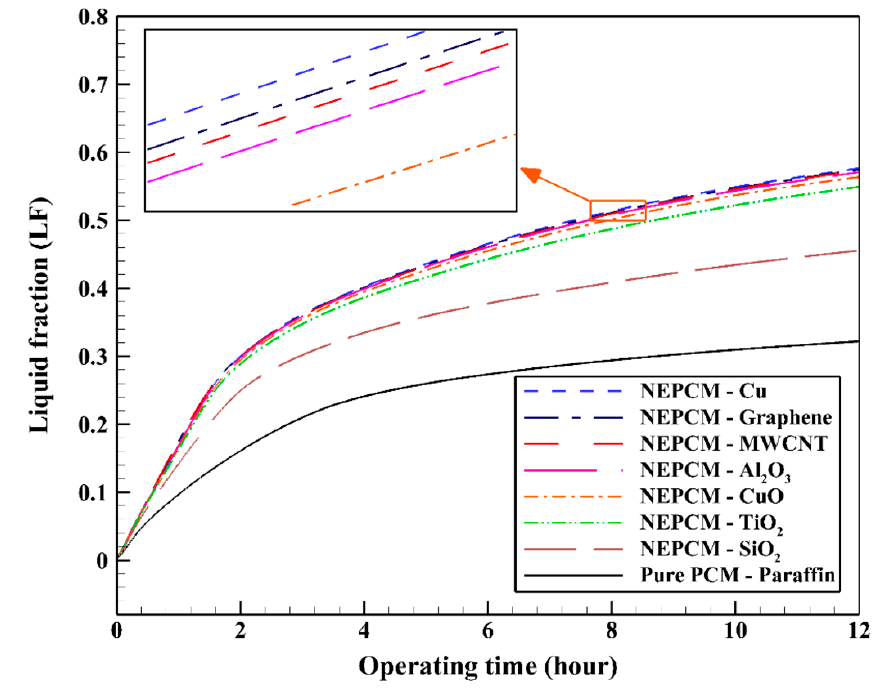
Figure 7. Liquid fractions of the different NePCMs tested over time by Javadi et al. (Copyright 2020 Javadi et al. https://creativecommons.org/licenses/by/4.0/) accessed on 18 June 2021